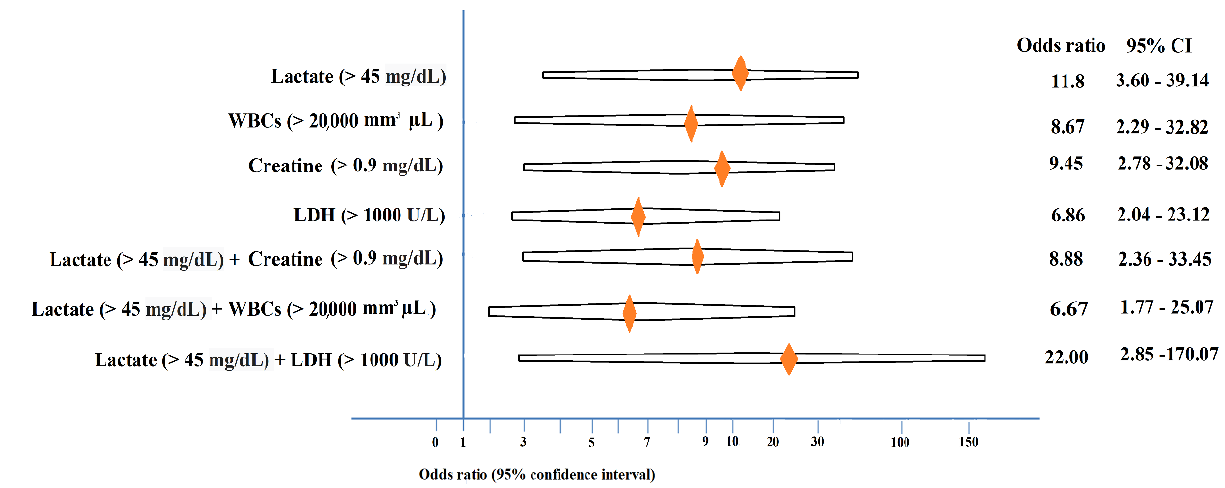
Figure 2. Odds ratio of different biomarkers for determining Sernat staging of patients with neonatal HIE.